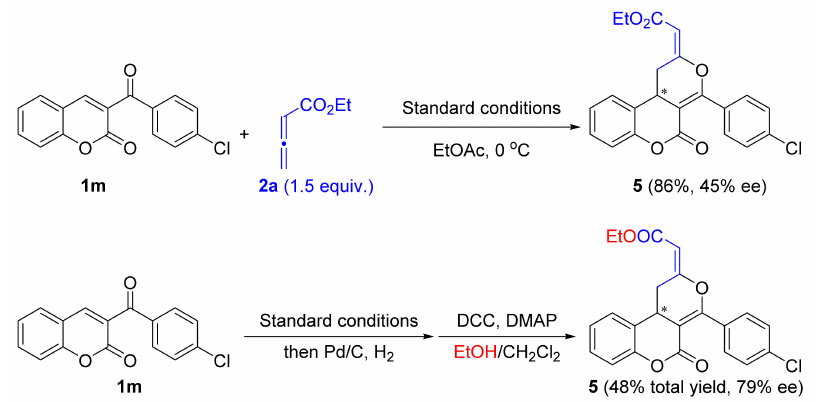
Figure 3. Z / E Configuration